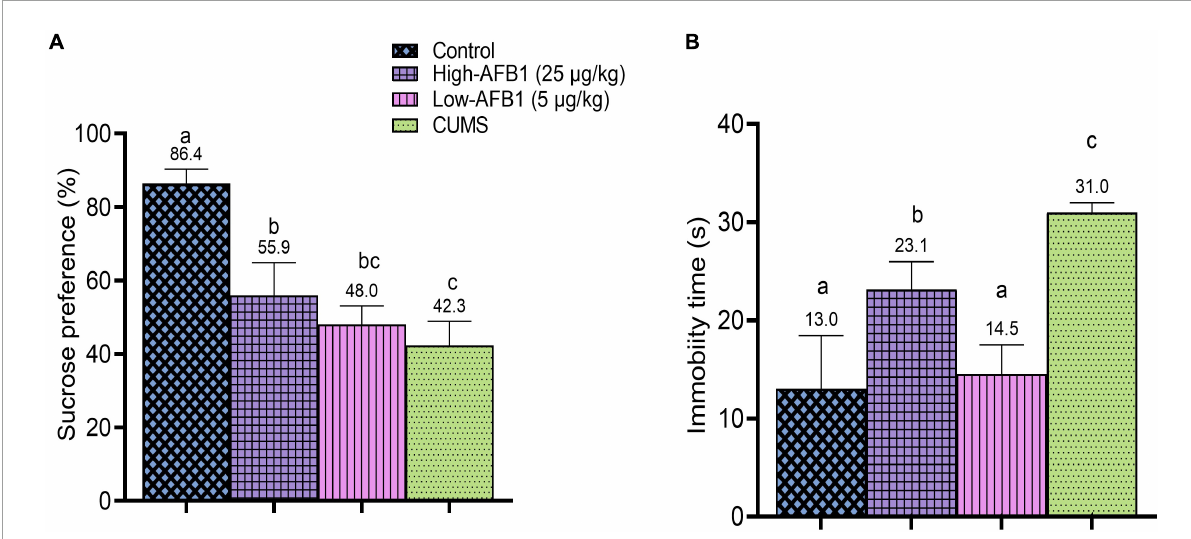
FIGURE3 (A) Sucrose preference (%) of rats after exposure to AFB 1 and CUMS treatment. (B) Immobility time(s) of rats in FST after exposure to AFB 1 and CUMS treatment. Error bars represents the data from mean ± SD, n = 8. Means between groups that do not share the same lowercase letters (a, b, c) are significantly different ( p < 0.05) using Tukey HSD post-hoc